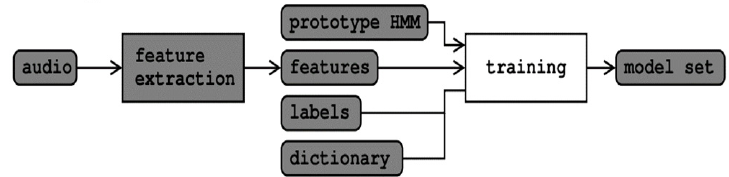
Figure 10. Block Diagram of the Training Processes.